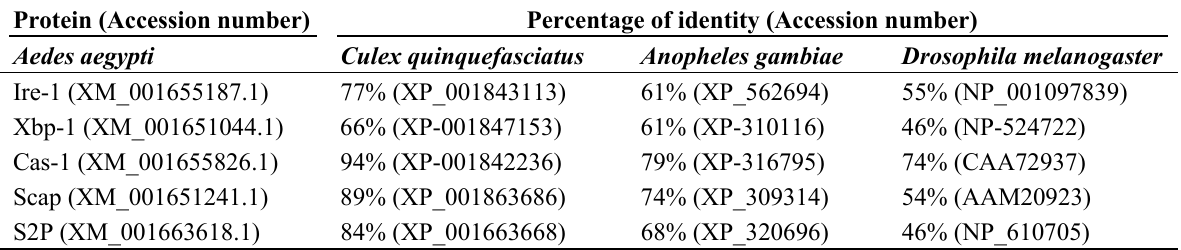
Table 2. Percentage of identity with similar proteins described in other